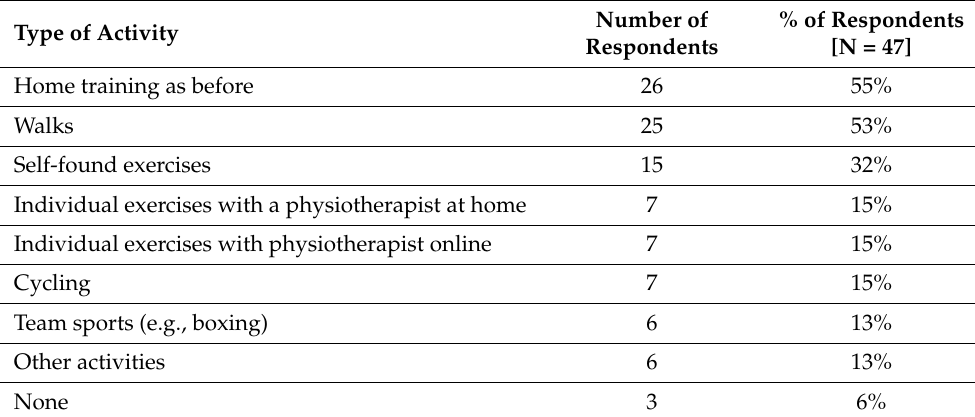
Table 2. Types of physical activities performed by people with PD during the pandemic.